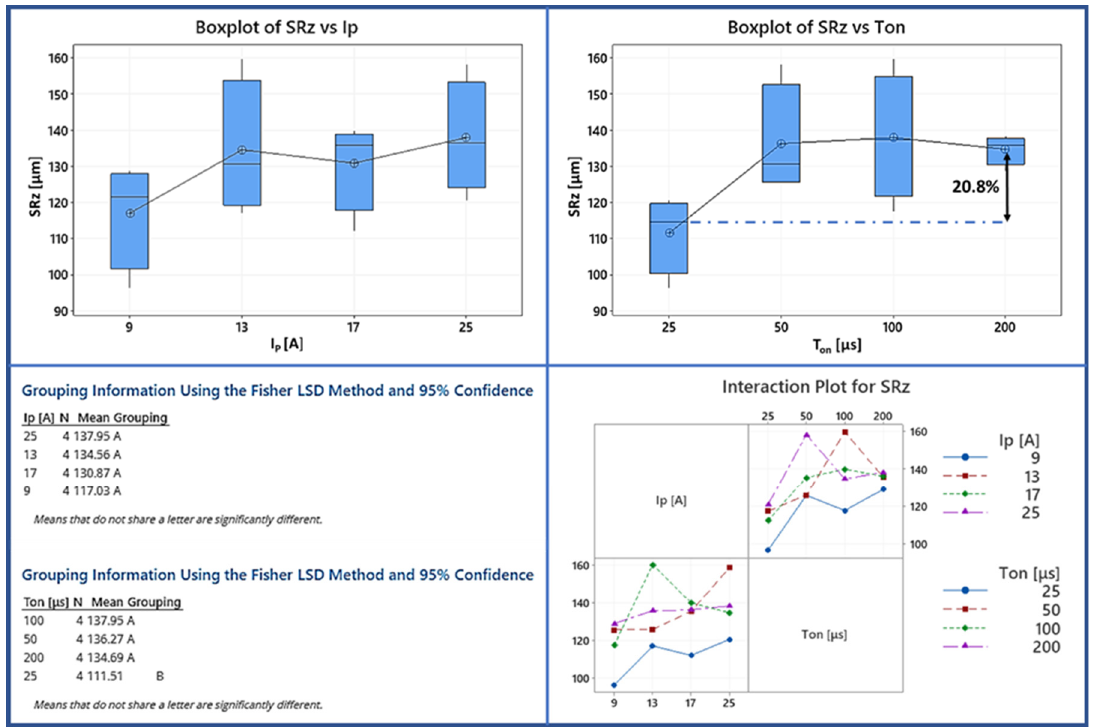
Figure 9. Box plot, interaction plot of TWR, and the results of the Fisher statistically significant test for SRz .